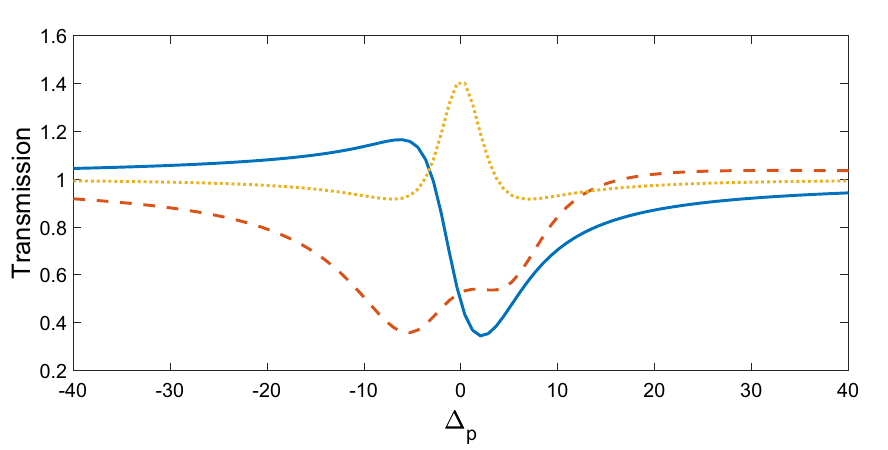
2 (dotted line). Other parameters are